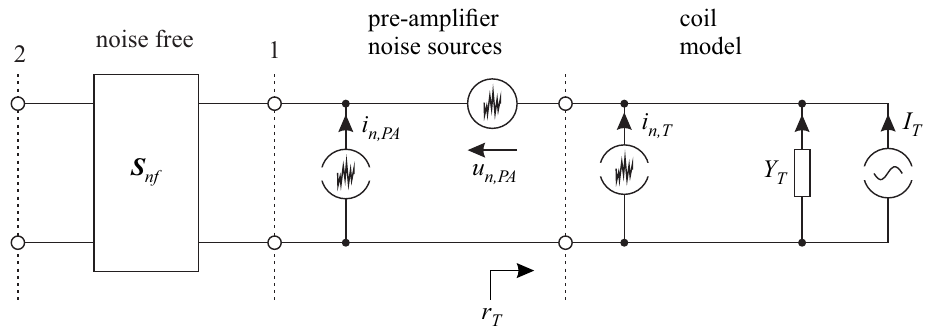
Figure 3. Noise model of pre-amplifier with a noise current source i n , PA and a noise voltage source u n , PA that can be partially correlated. The noise sources are positioned at the input port of the noise free S-parameter network S nf of the pre-amplifier. The coil signal that is received in the pre-amplifier plane will be modeled as a current source I T . The corresponding source admittance will be denoted as Y T and the reflection coefficient as r T . The noise contribution of the coil is described by the noise source i n , T